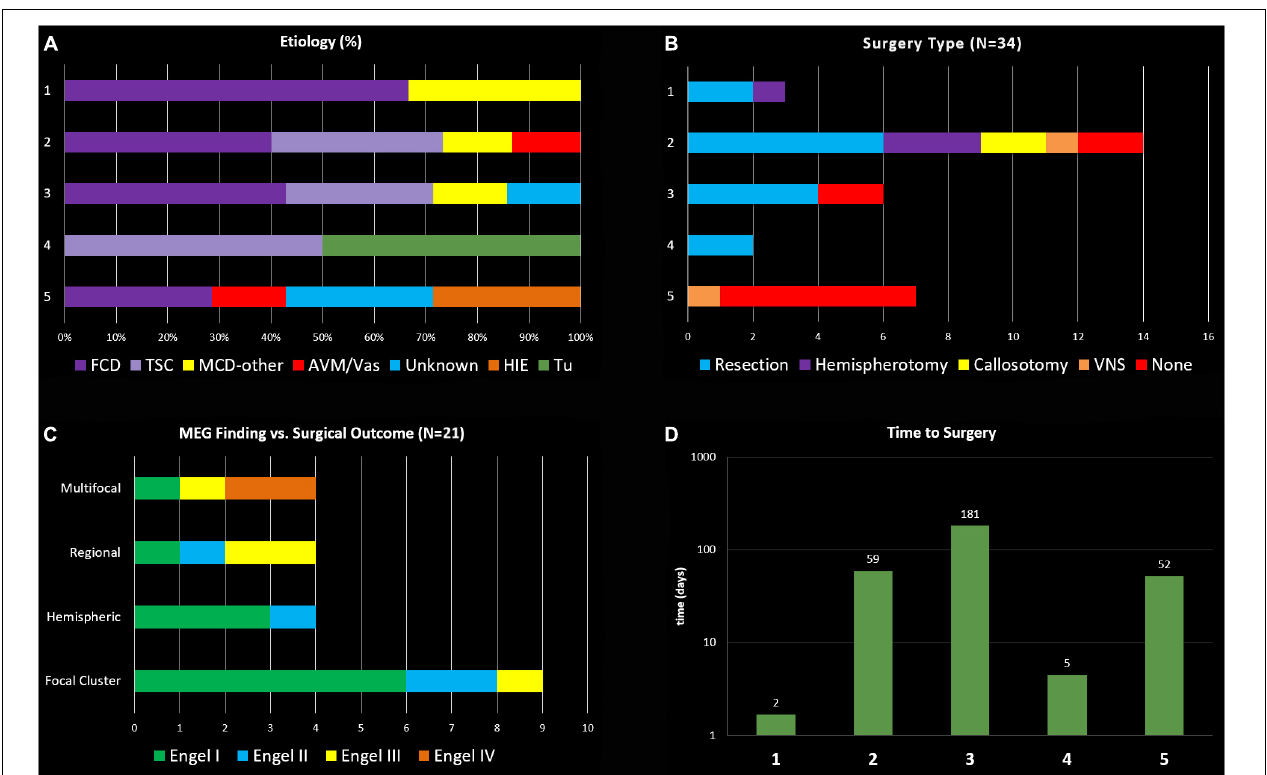
FIGURE 1 | (A) General etiology types for the 5 clinical indication groups (FCD, focal cortical dysplasia; TSC, tuberous sclerosis complex; MCD, migration disorder of cortical development; AVM, arterio-venous malformation, Vas vascular; HIE, hypoxic-ischemic encephalopathy; Tu, tumor). (B) Distribution of surgical interventions in the five groups. (C) Main MEG findings and respective surgical outcomes. (D) Logarithmic display of days between MEG recording and surgical intervention in the